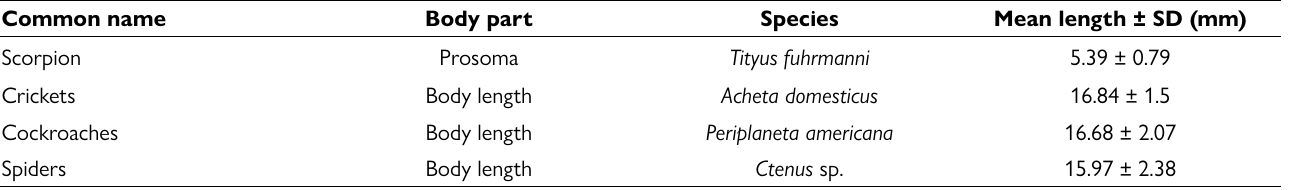
Table 1. Mean lengths of Tityus fuhrmanni and prey used in behavioral experiments: cockroaches ( Periplaneta americana ), crickets ( Acheta domesticus ) and spiders ( Ctenus sp.). Common